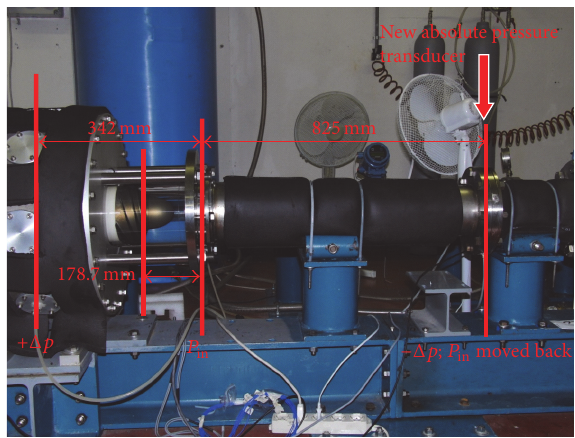
Figure 3: Test section setup for the characterization of the noncav- itating performance of the inducer.